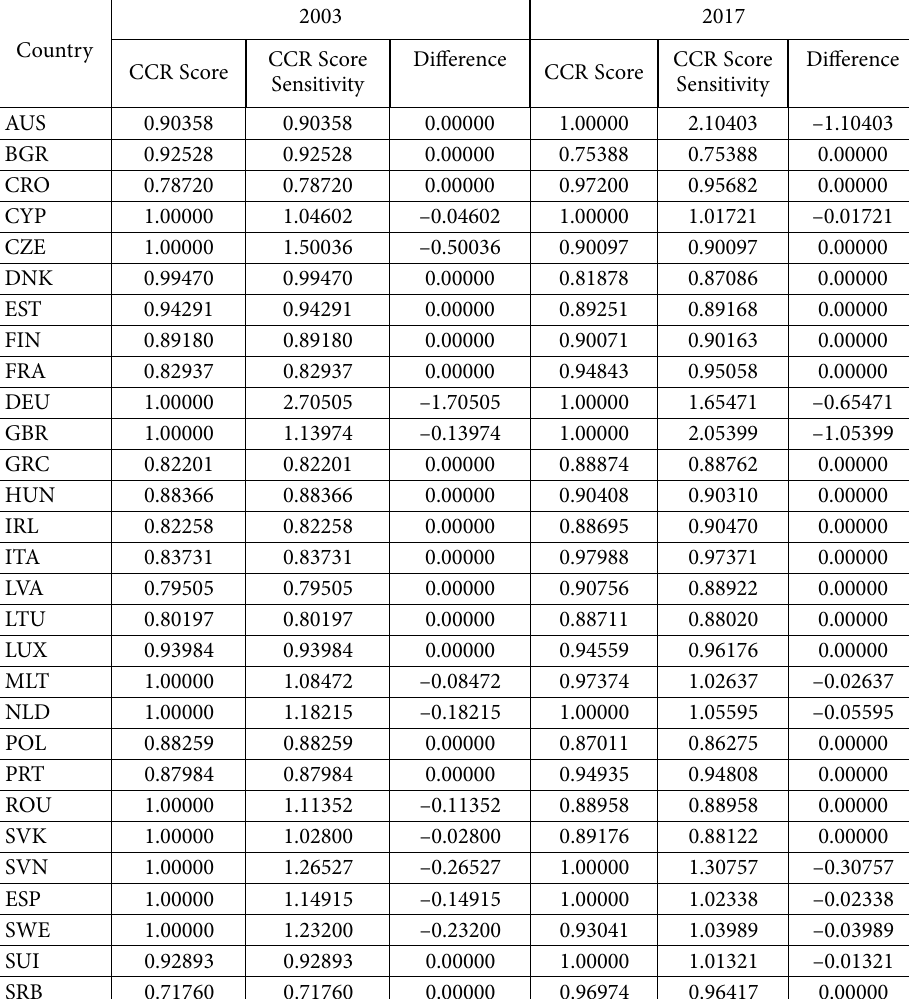
Table 5. Efficiency scores and productivity changes (source: calculated by the authors based on data from Universal Postal Union